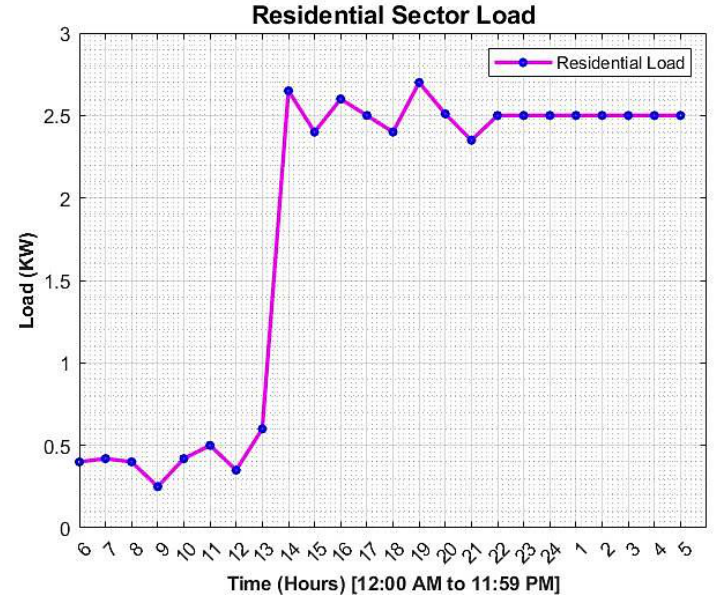
Figure 4. Residential load for a single day.